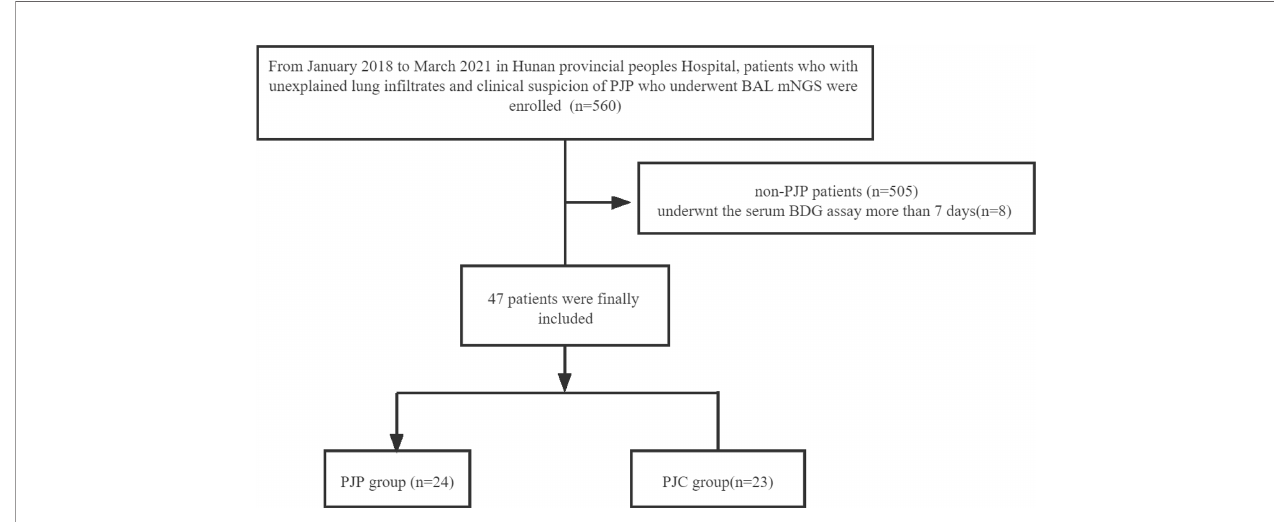
CHART 1 | Flow diagram of the patients included in the